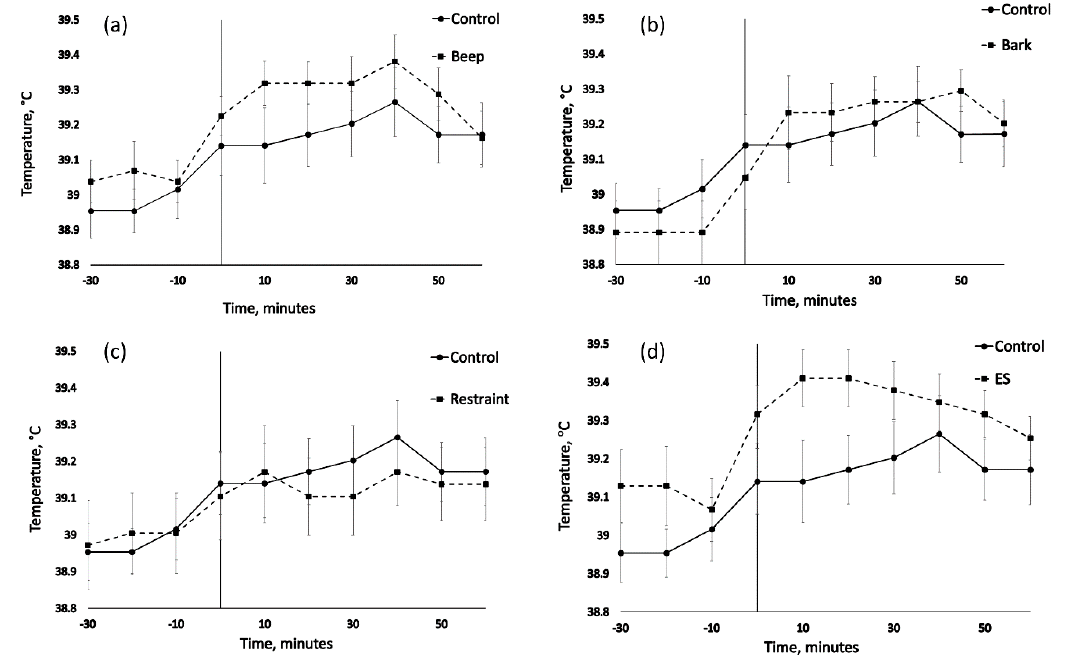
Figure 2. The effect of physical and auditory stimuli on mean (± s.e.m) vaginal temperature (°C) in sheep. Control comparison to treatments ( a ) beep, ( b ) bark, ( c ) restraint, and ( d ) ES = electrical stimulus treatment.